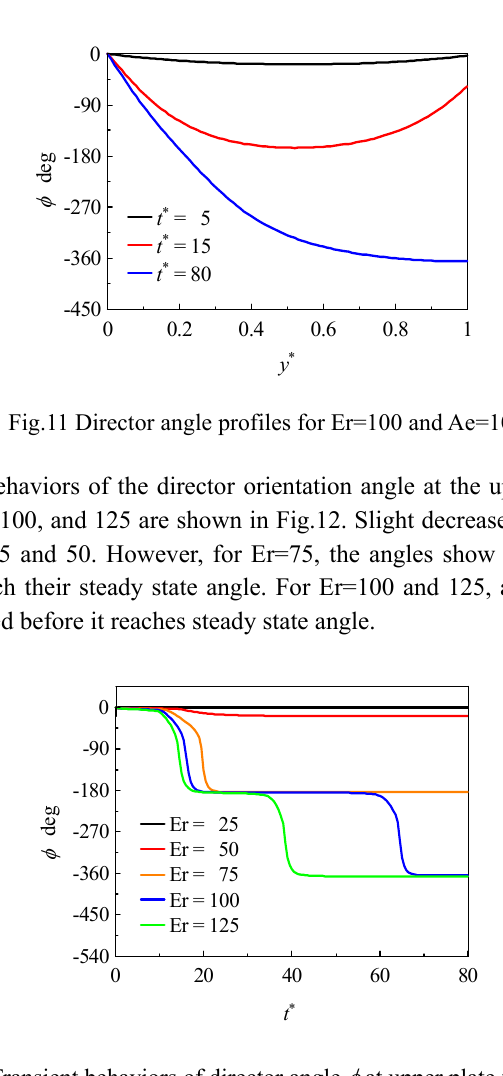
Fig.12 Transient behaviors of director angle φ at upper plate for